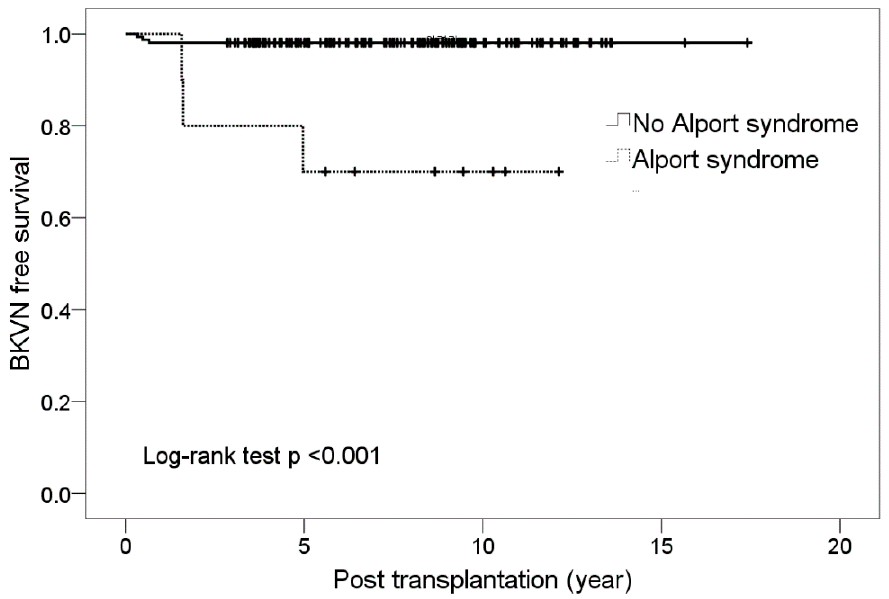
Figure 2. Kaplan–Meier curves indicating progression to BK virus nephropathy after renal transplantation.